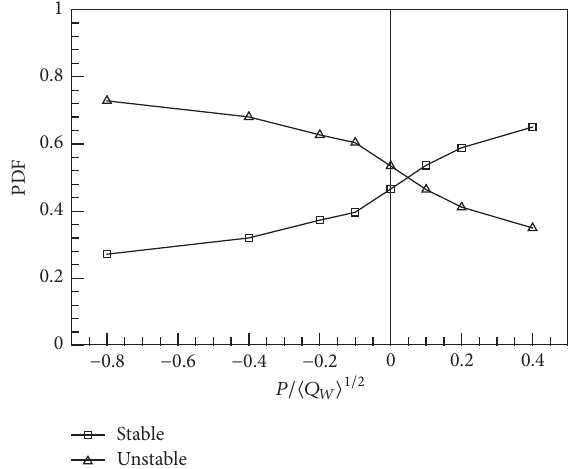
Figure 10: Probability evolution of stable and unstable topologies in the flame zone ( 𝑡 = 501 𝜇